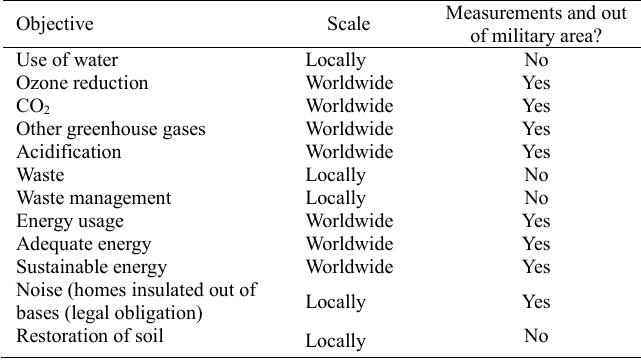
Table 2: Environmental impact consideration at the local and global level Objective